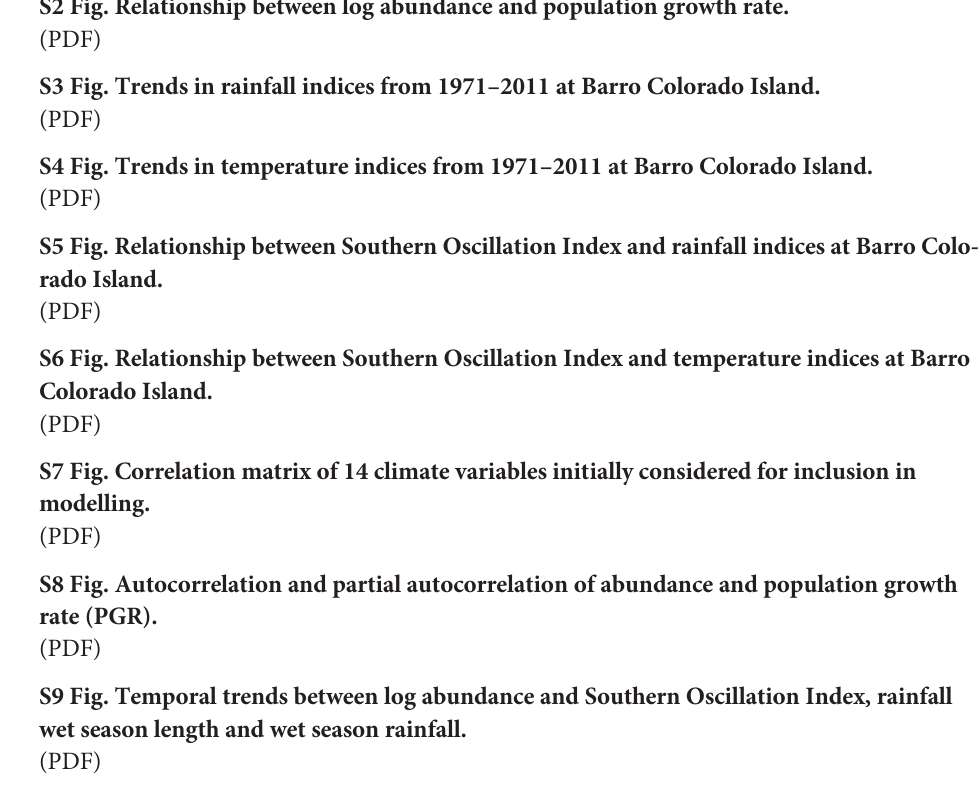
S2 Fig. Relationship between log abundance and population growth rate. (PDF) S3 Fig. Trends in rainfall indices from 1971 – 2011 at Barro Colorado Island. S4 Fig. Trends in temperature indices from 1971 – 2011 at Barro Colorado Island. S5 Fig. Relationship between Southern Oscillation Index and rainfall indices at Barro Colo- rado Island. S6 Fig. Relationship between Southern Oscillation Index and temperature indices at Barro Colorado Island. S7 Fig. Correlation matrix of 14 climate variables initially considered for inclusion in modelling. S8 Fig. Autocorrelation and partial autocorrelation of abundance and population growth rate (PGR). S9 Fig. Temporal trends between log abundance and Southern Oscillation Index, rainfall wet season length and wet season rainfall. S10 Fig. Temporal trends between log abundance and minimum temperature, maximum temperature, number days exceeding field-preferred body temperature, maximum dry sea- son temperature and maximum wet season temperature. S11 Fig. Temporal trends between population growth rate and southern oscillation index, rainfall, wet season length and wet season rainfall. S12 Fig. Temporal trends between population growth rate and minimum temperature, maximum temperature, number days exceeding field-preferred body temperature, maxi- mum dry season temperature and maximum wet season temperature. S13 Fig. Temporal covariation of log abundance and population growth rate and cross cor- relation between population growth rate and abundance. S14 Fig. Cross correlation of log abundance and southern oscillation index, rainfall, wet season length and wet season rainfall. S15 Fig. Cross correlation of log abundance and minimum temperature, maximum tem- perature, number days exceeding field-preferred body temperature, maximum dry season temperature and maximum wet season